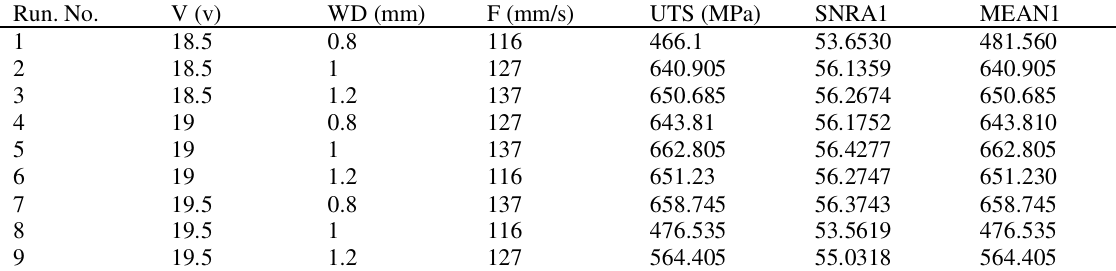
Results of Statistical Analysis of Experiments by Taguchi technique for UTS Run. No.